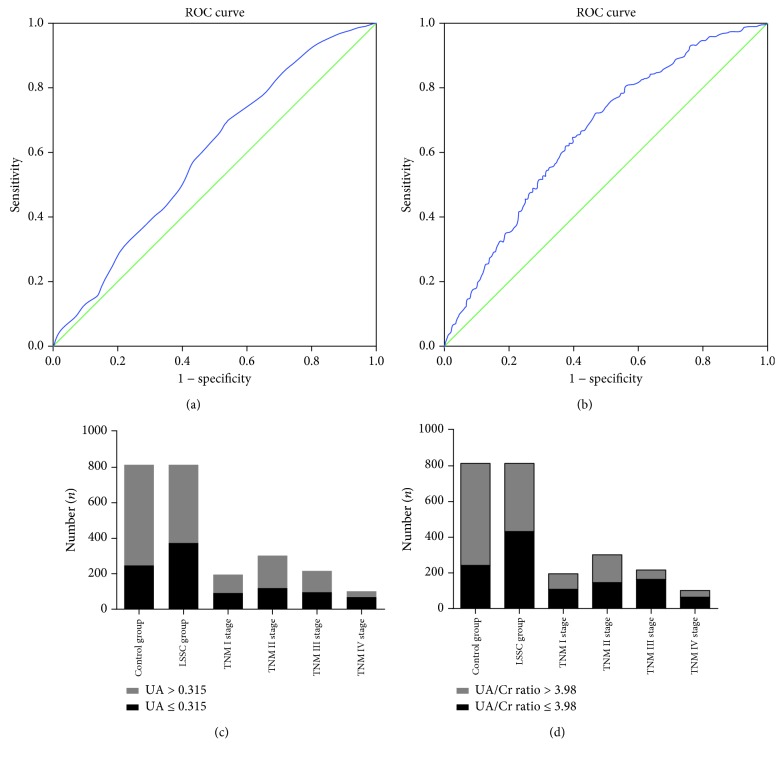
Receiver operating characteristic (ROC) curve analysis for uric acid (UA) (a) and the UA/Cr ratio (b) in predicting laryngeal squamous cell cancer (LSCC). The patients with different LSCC severities (TNM stages) and the control group were stratified by UA (c) and the UA/Cr ratio (d).